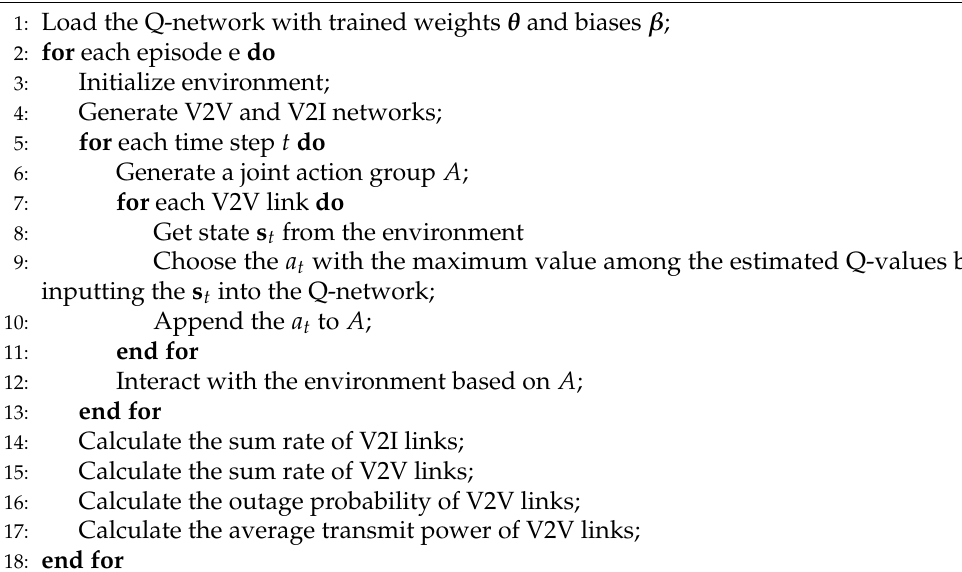
Algorithm 2 Testing